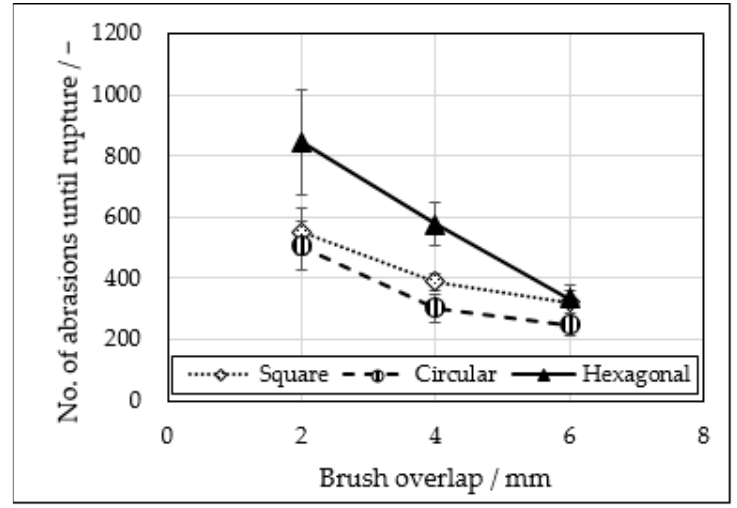
Figure 9. Number of abrasions until rupture of the thin nylon cloth for 2, 4 and 6 mm for a square, a circular and a hexagonal edge geometry.